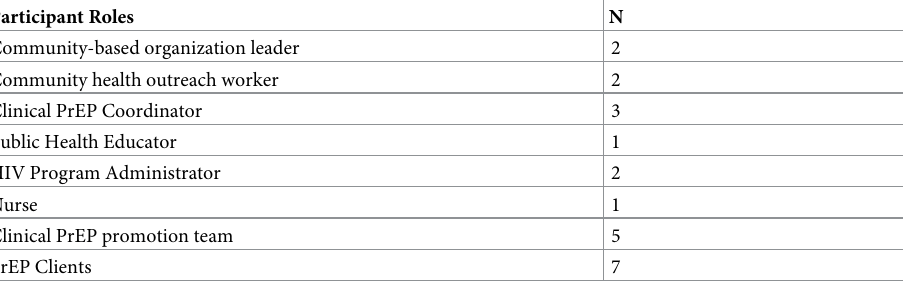
Table 1. Description of participant